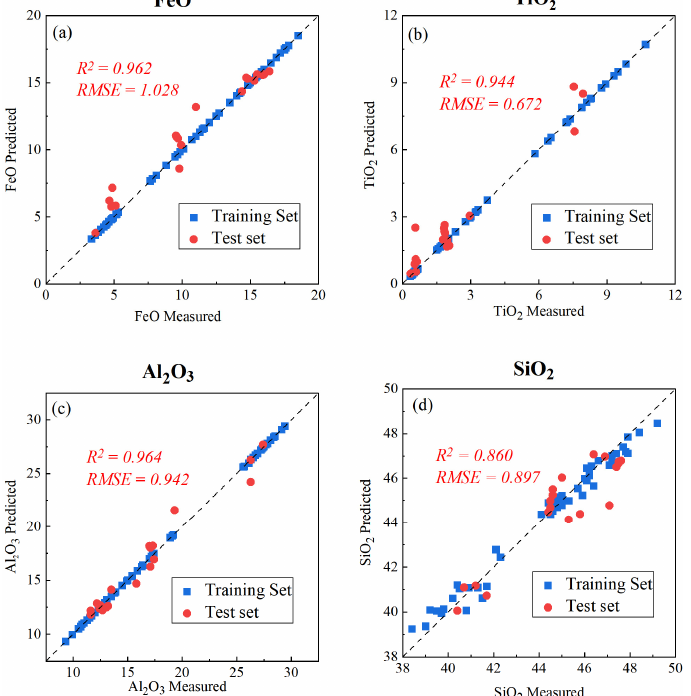
Figure 8. Training and testing accuracy of the Extra-Trees model with chemical abundance based on feature band selection: ( a ) FeO, ( b ) TiO 2 , ( c ) Al 2 O 3 , and ( d ) SiO 2 .